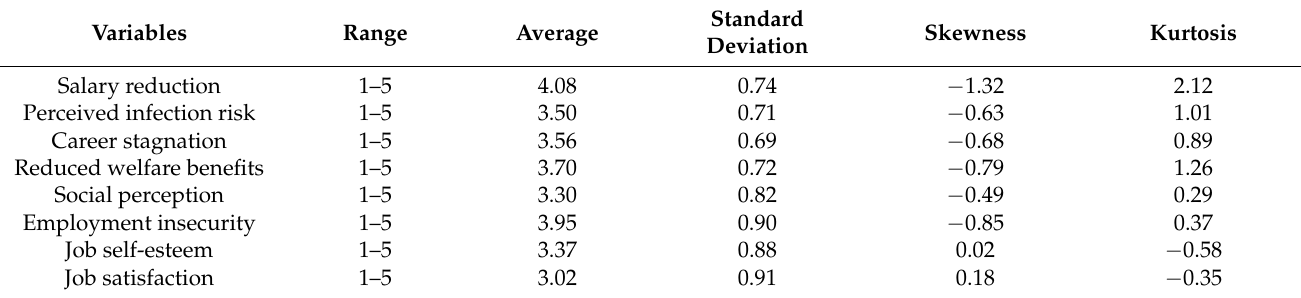
Table 6. Descriptive statistics analysis result.